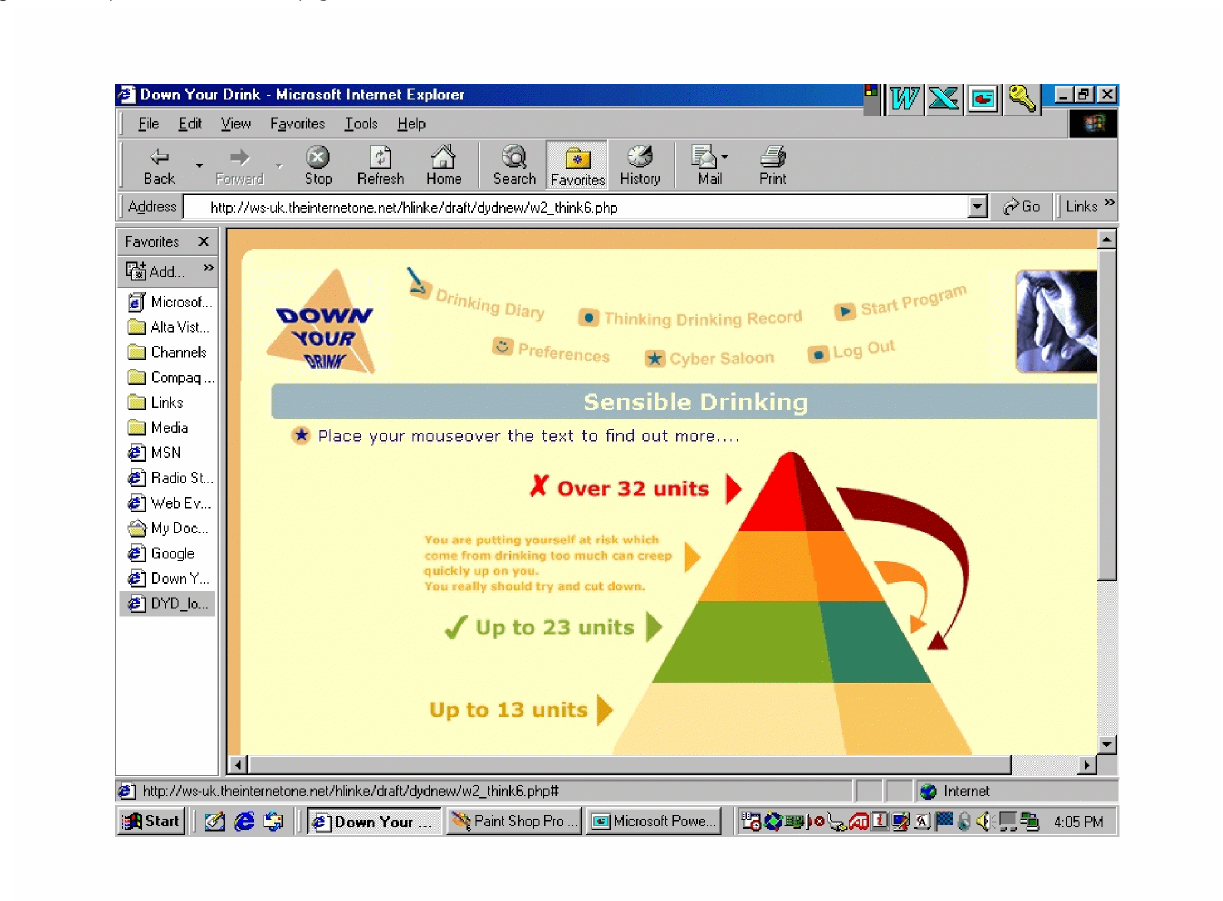
Figure 2. Sample Down Your Drink